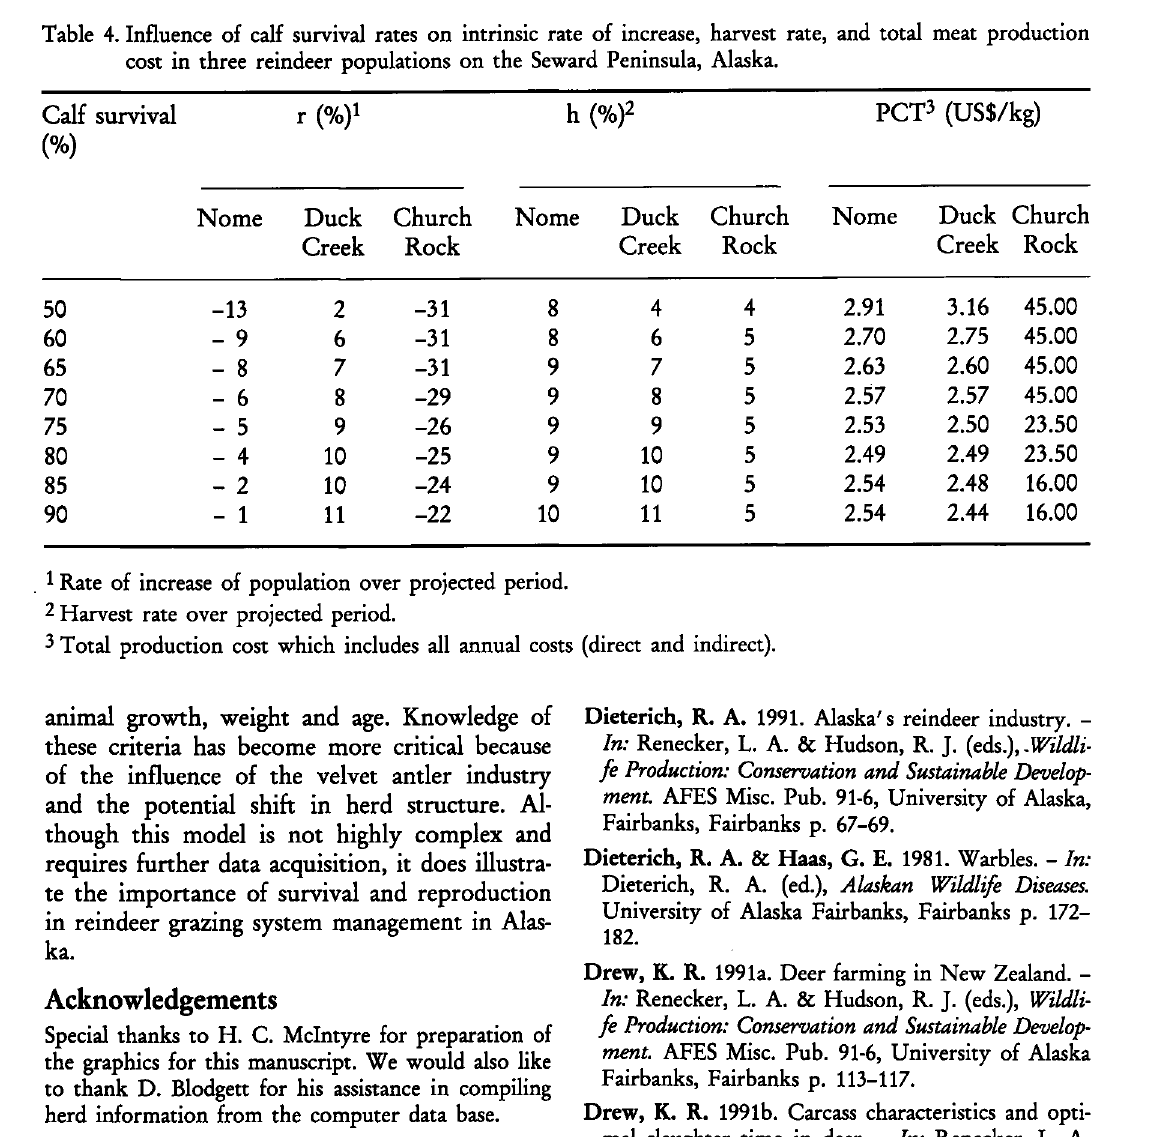
Table 4. Influence of calf survival rates on intrinsic rate of increase, harvest rate, and total meat production cost in three reindeer populations on the Seward Peninsula, Alaska. Calf